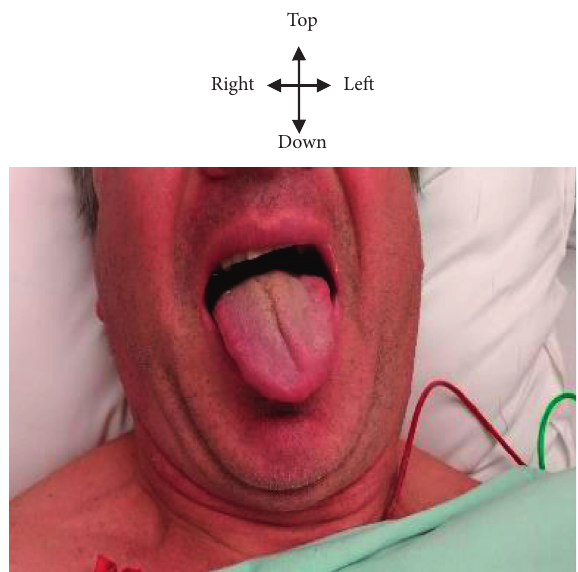
Figure 1: Left ipsilateral deviation of the tongue to protraction